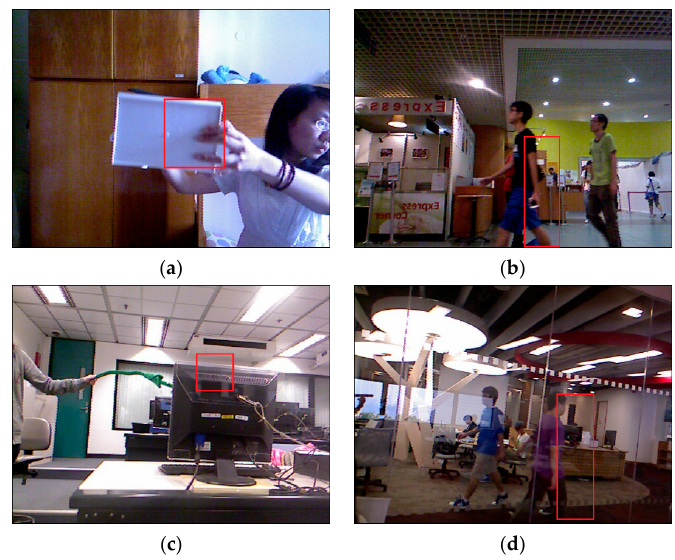
Figure 11. The“bad” tracking results of our method. ( a ) Frame 47 in test video 1; ( b ) Frame 93 in test video 1; ( c ) Frame 66 in test video 3; ( d ) Frame 37 in test video 3.